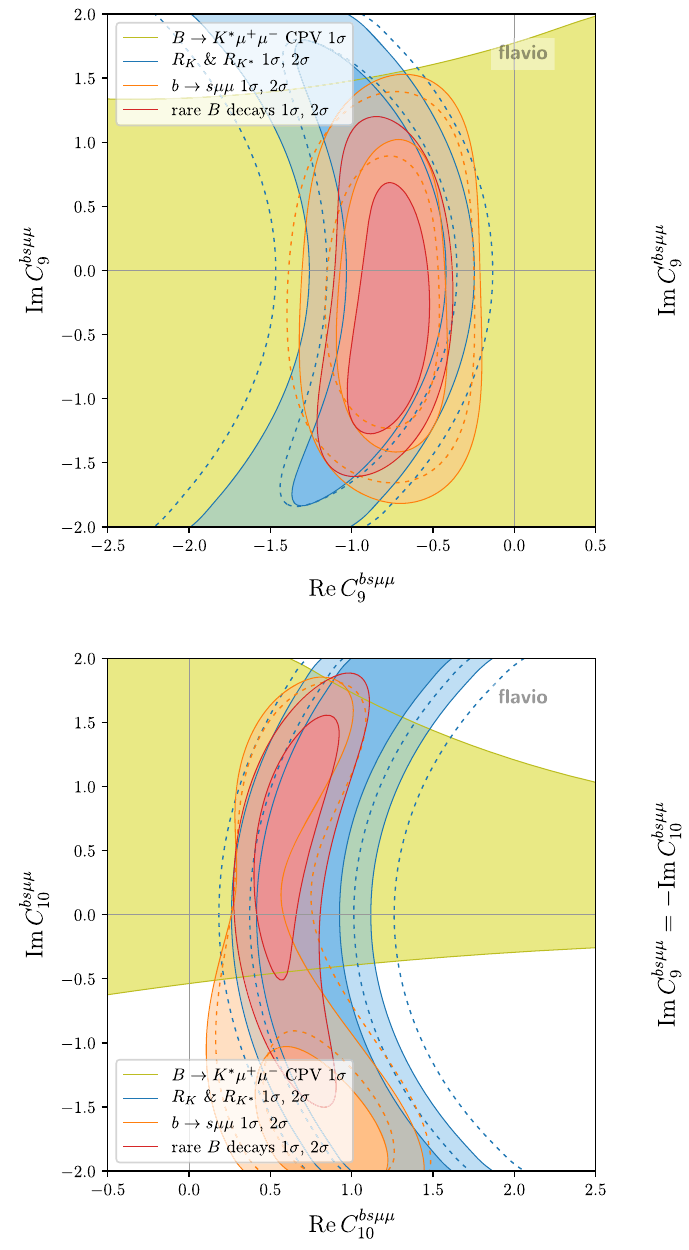
μμ (cid:6) bs μμ serving b → s μμ observables, the B → K ∗ μ + μ − CP asymmetries, (top left), C 9 9 μμ and the global fit. The dashed lines show the constraints before the = − C bs μμ (bottom right). 9 10 recent updates